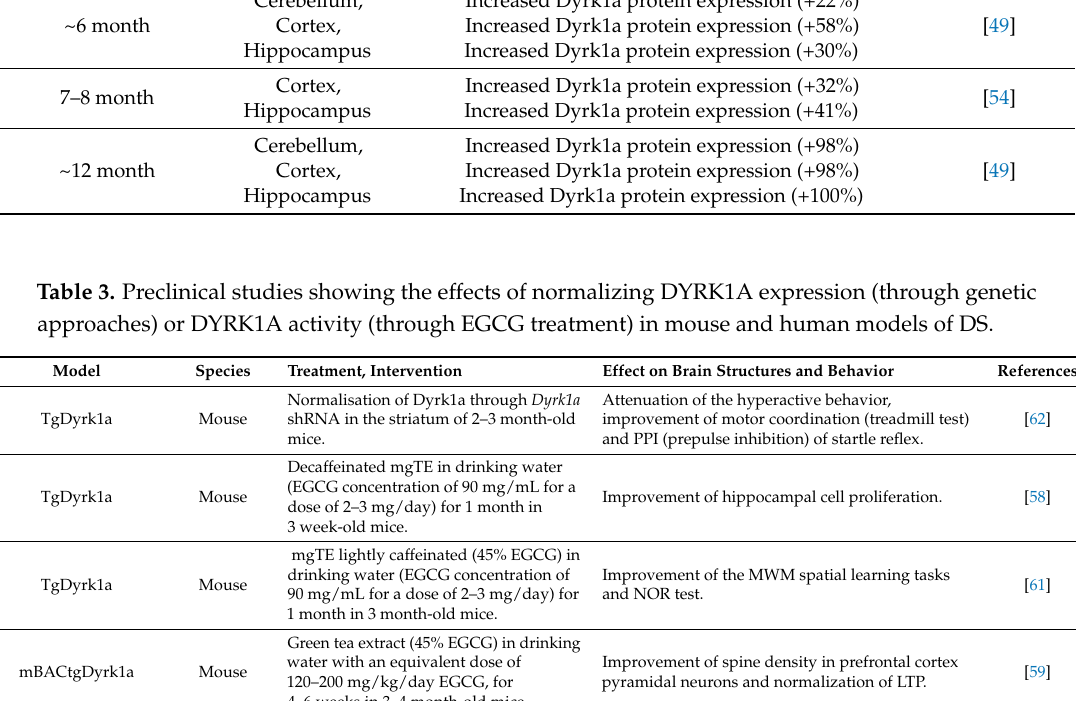
Improvement of the MWM spatial learning tasks and NOR test. Improvement of spine density in prefrontal cortex pyramidal neurons and normalization of